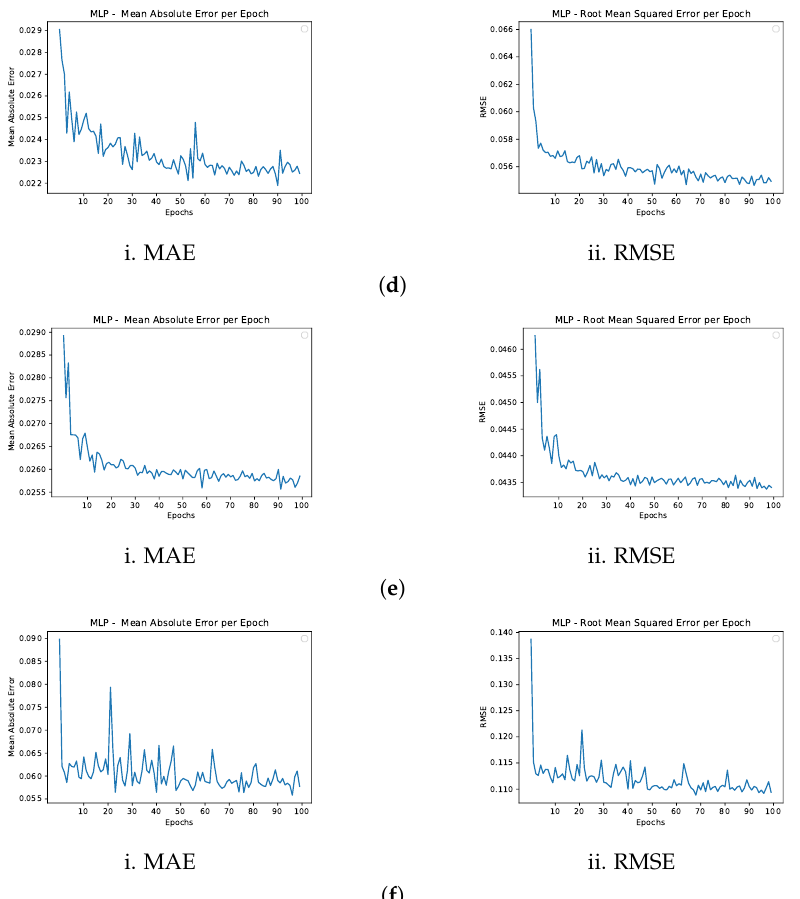
Figure 10. Metrics for the MLP Model. ( a ) Error Metrics for ANL-Intrepid-2009-1 Dataset. ( b ) Error Metrics for CEA-Curie-2011-2 Dataset. ( c ) Error Metrics for CIEMAT-Euler-2008-1 Dataset. ( d ) Error Metrics for KIT-FH2-2016-1 Dataset. ( e ) Error Metrics for METACENTRUM-2013-3 Dataset. ( f ) Error Metrics for UniLu-Gaia-2014-2 Dataset.